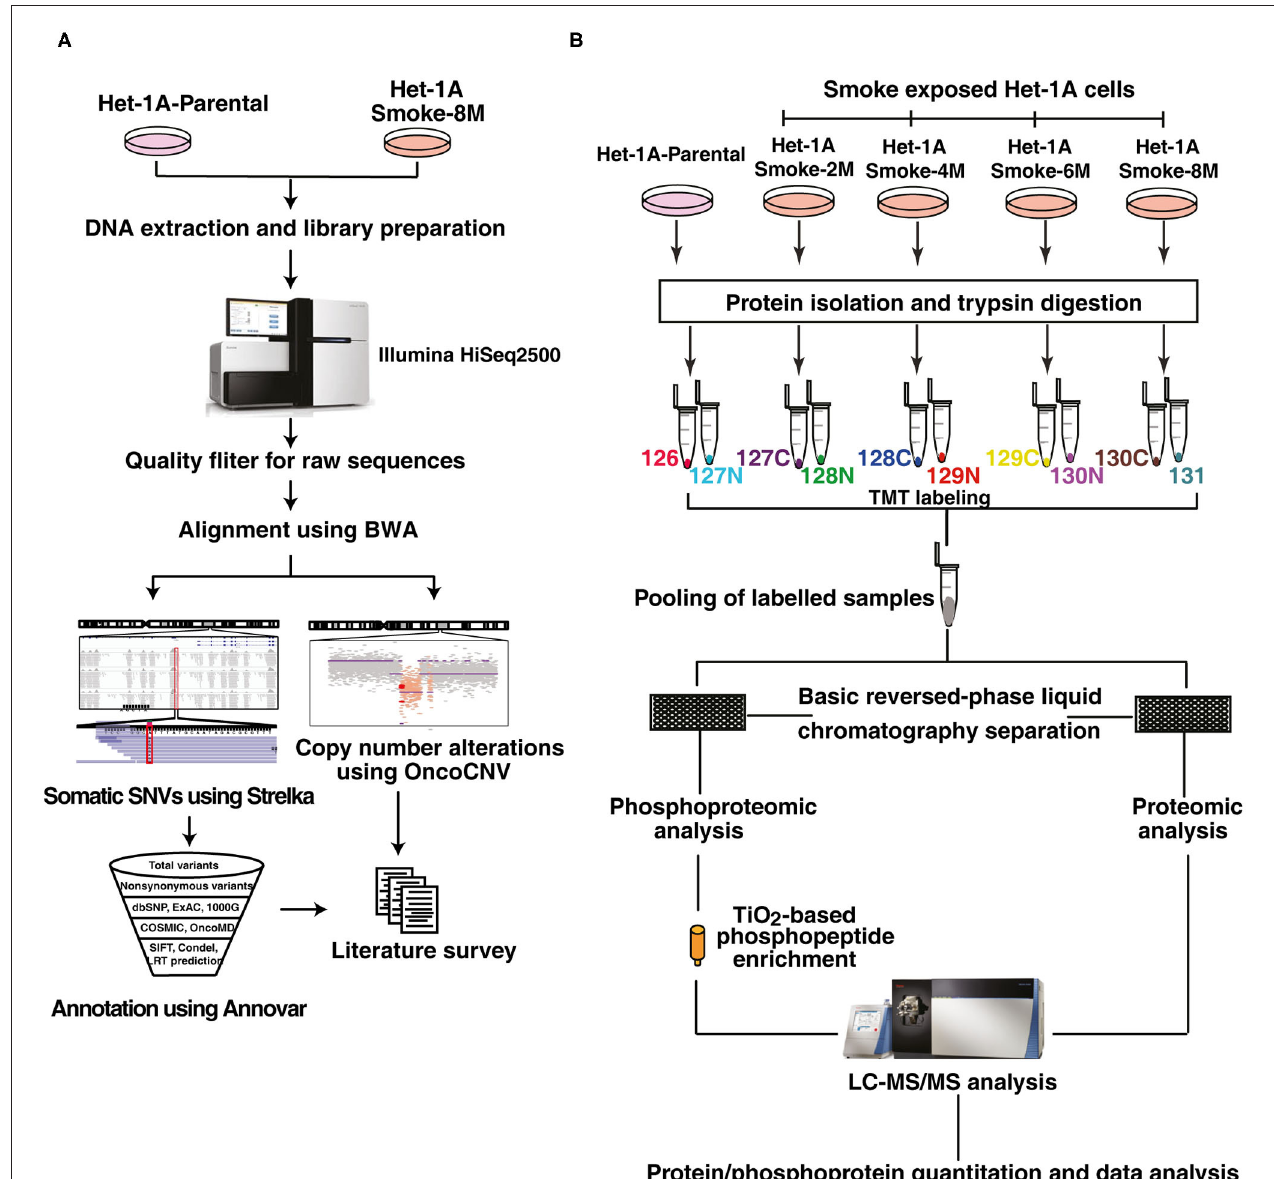
FIGURE 2 | Workflow employed for exome sequencing, proteomic and phosphoproteomic analysis. (A) Workflow employed for whole exome sequencing of CSC treated and untreated Het-1A cells. Het-1A-Parental and Het-1A-Smoke-8M cells were harvested at 80% confluence and genomic DNA was extracted. Whole exome sequencing was done using Illumina HiSeq2500. Raw reads obtained were filtered and computational analysis was done for single nucleotide variants and copy number variants. (B) Workflow employed for proteomic and phosphoproteomic analysis. Proteins were extracted and quantified from Het-1A-Parental, Het-1A-Smoke-2M, Het-1A-Smoke-4M, Het-1A-Smoke-6M, and Het-1A-Smoke-8M cells. In-solution trypsin digestion of equal amount of proteins from each condition was performed and peptides were labeled with TMT reagents. Ten percent of each sample was pooled and fractionated using basic reversed phase liquid